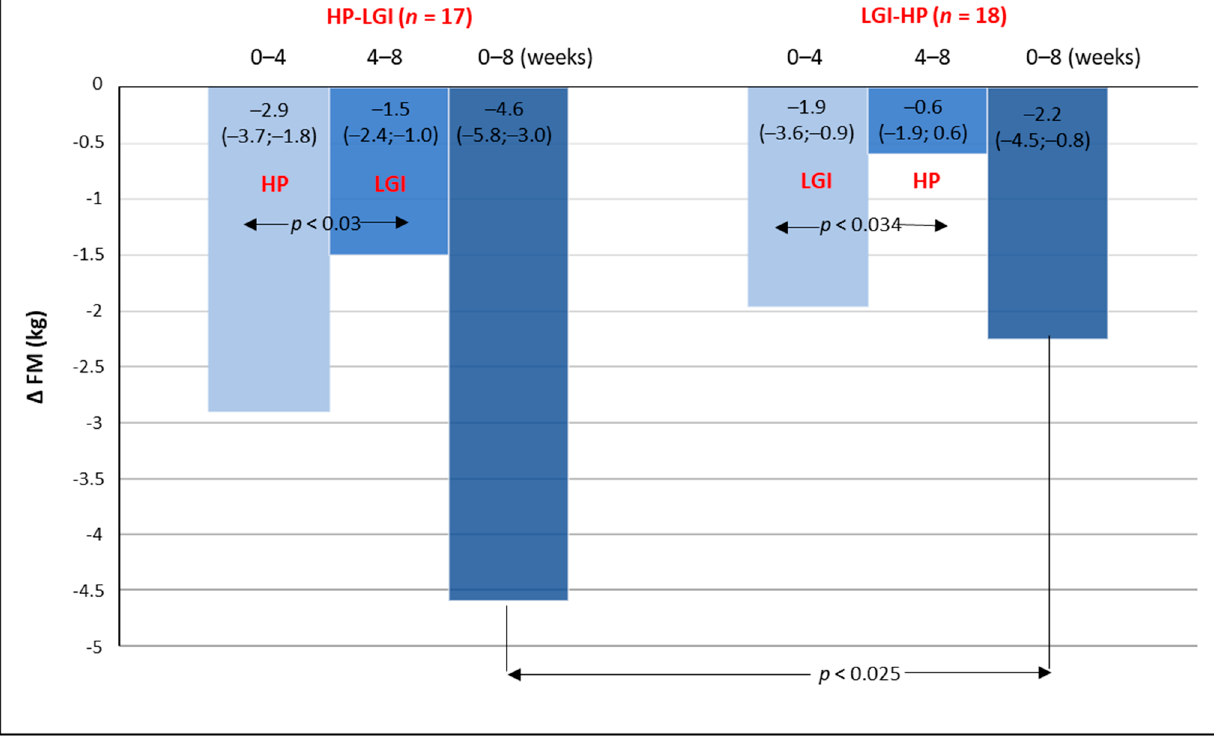
Figure 3. The changes in fat mass ( ∆ FM) during the 8-week period of energy-restricted diets: 4-week high protein (HP) or low glycemic index (LGI) diets given in a random order and followed by the opposite diet.